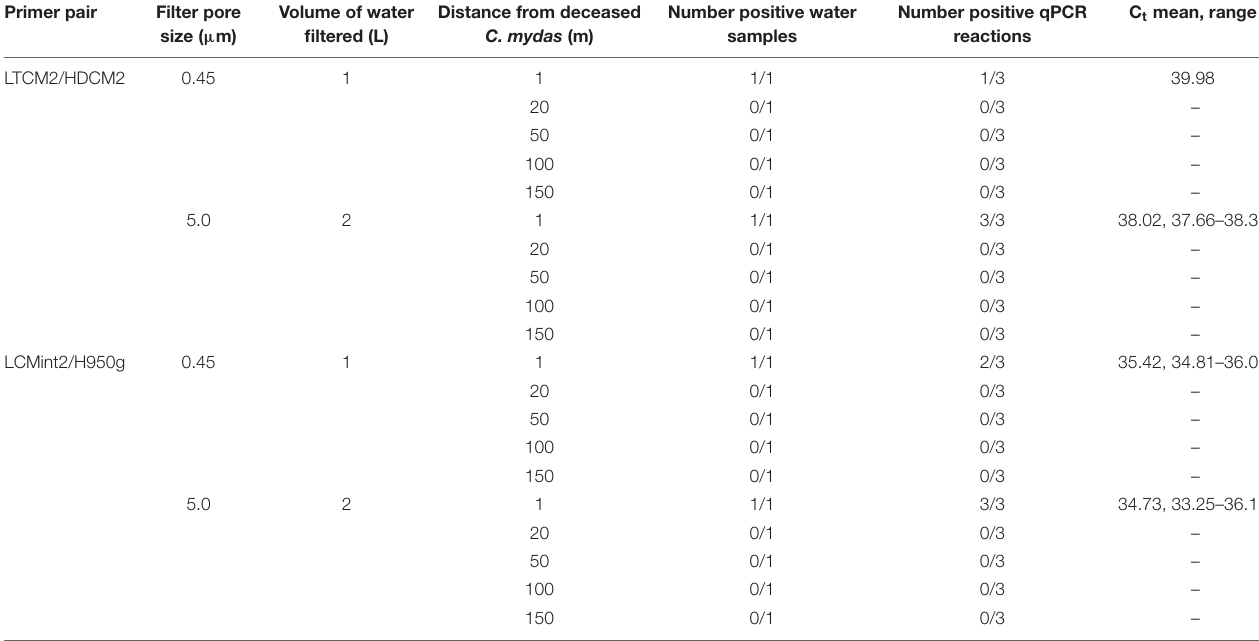
TABLE 5 | Comparison of Chelonia mydas eDNA detection in San Diego Bay with distance from a deceased turtle present on shore. Primer pair Filter pore size ( µ